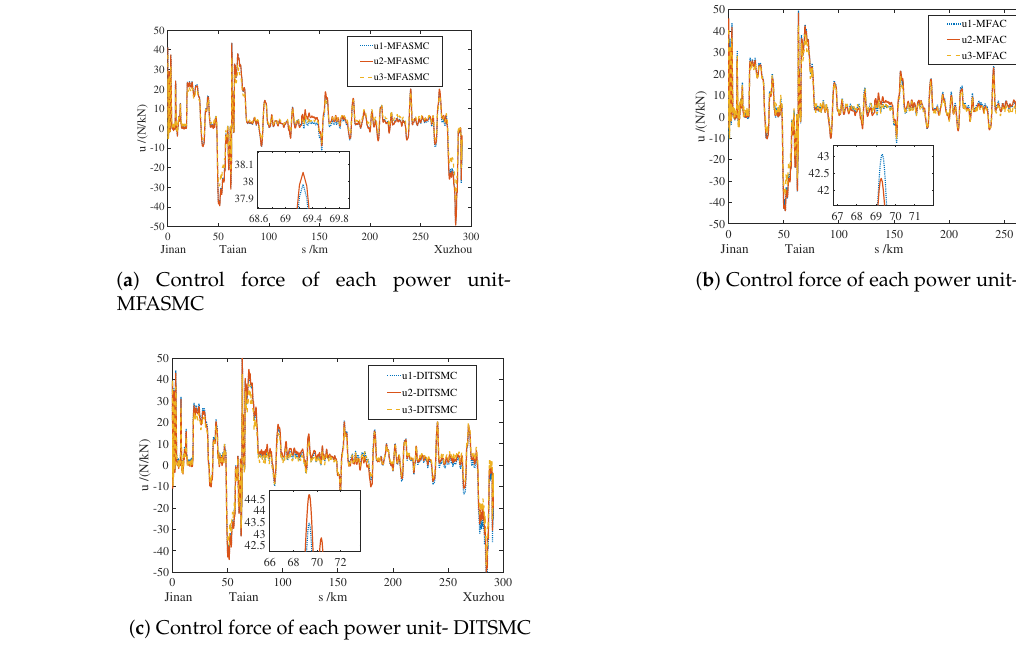
Figure 12. Control force curves of each power unit for the three methods.